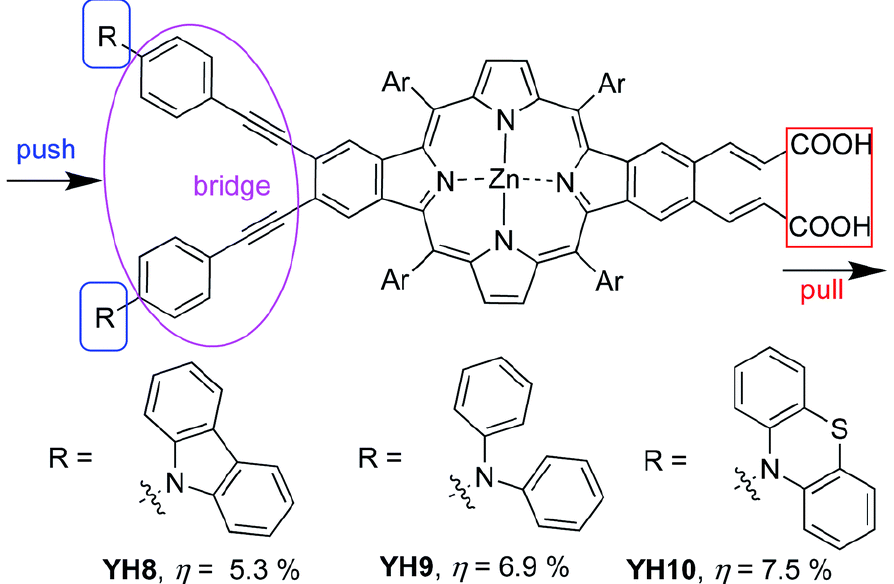
Figure 24. Molecular structures of the porphyrin dyes for the investigation of the push group effect on β -functionalized push – pull dibenzoporphyrins. Adapted from reference [101] with permission from the Royal Society of Chemistry, copyright 2021.